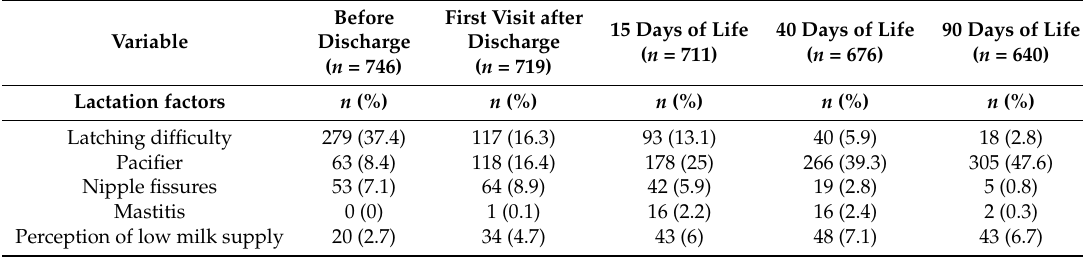
Table 2. Follow-up findings.